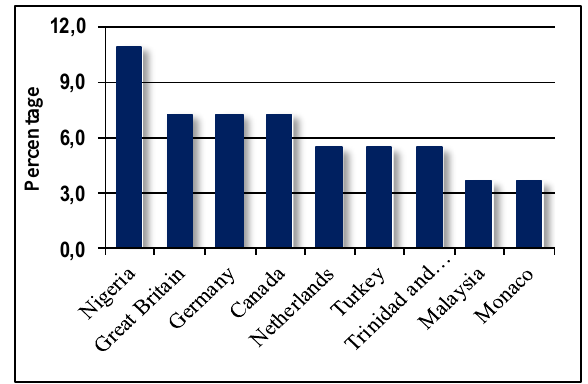
Figure 2. Countries making major contribution in implementation and research related to Hydrography: planning, environment, water resources management